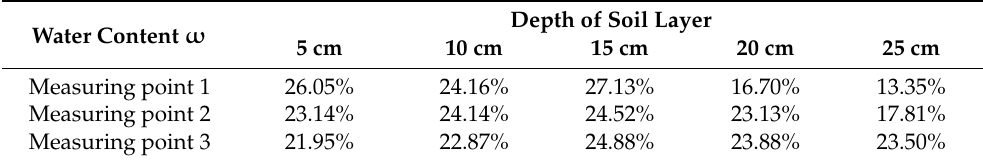
Figure 13. Distribution of water content measuring points. Table 4. Water content at different depths of each measuring